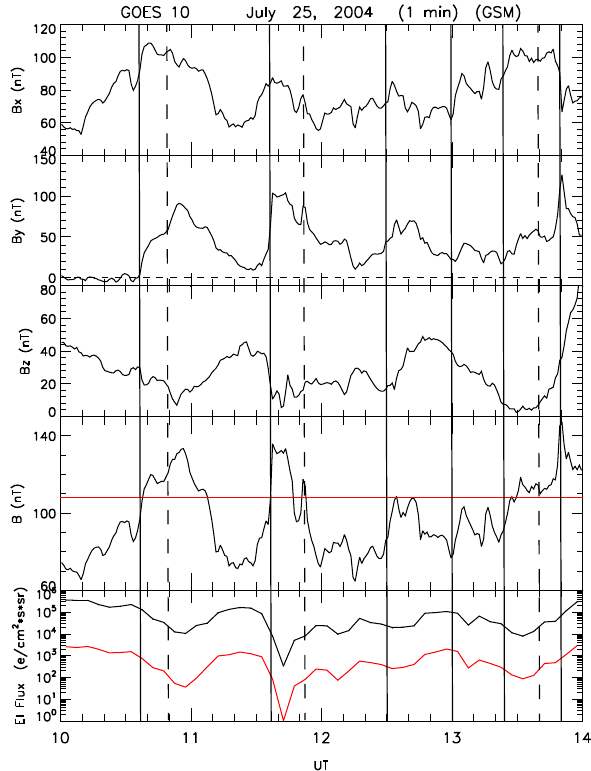
Figure 2. GOES-10 data during the interval 10:00–14:00UT. Pan- els from top to bottom show the magnetic field components B x , B y , B z , the total field B, and (bottom) electron fluxes in black ( > 0.6MeV) and red ( > 2MeV) traces. Vertical guidelines mark changes in field orientation and magnitude accompanied by elec- tron flux decreases (increases). See text for